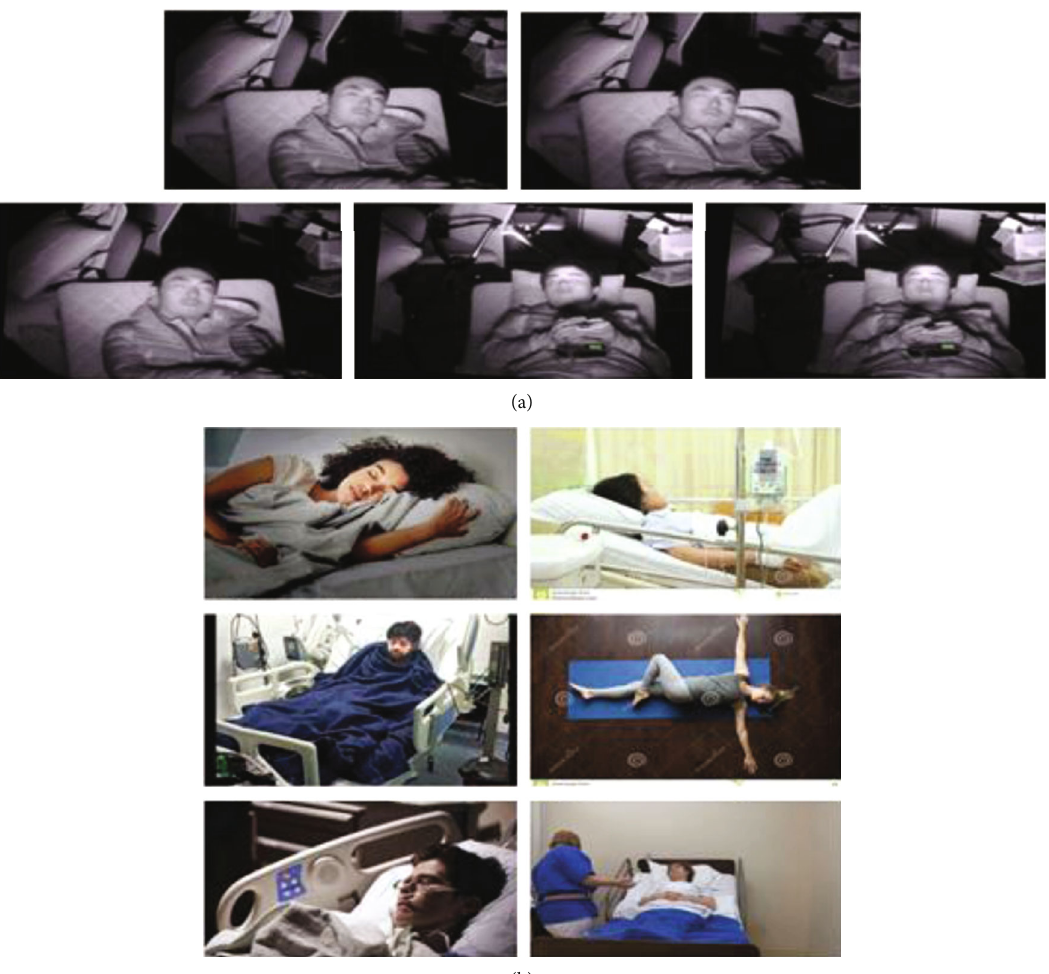
Figure 6: (a) Extraction of image frames from the sleep video. (b) The subset of the MPII dataset based on the extracted sleep posture.